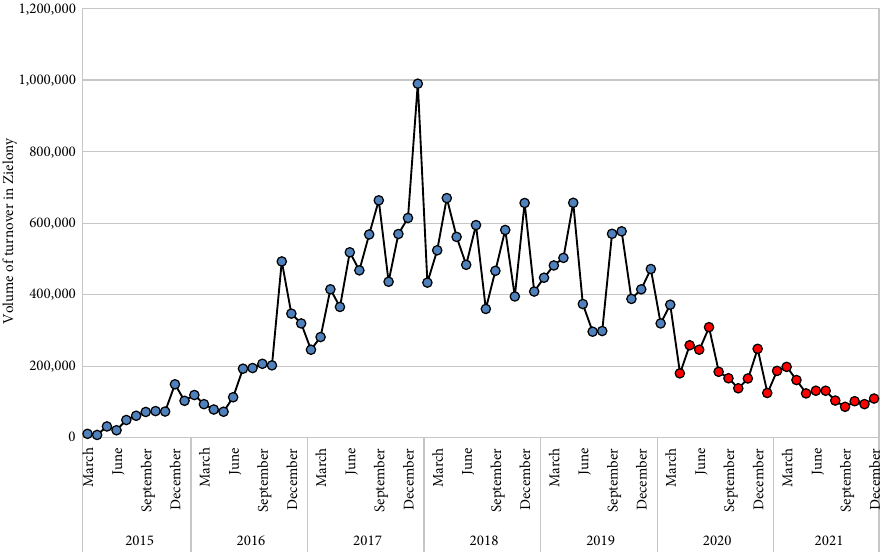
Figure 5. The volume of turnover generated in the system between 2015 and 2021 (in Zielony) (source: own elaboration based on Stępnicka et al., 2021; data obtained from the administrator of the Zielony complementary currency system in 2022)